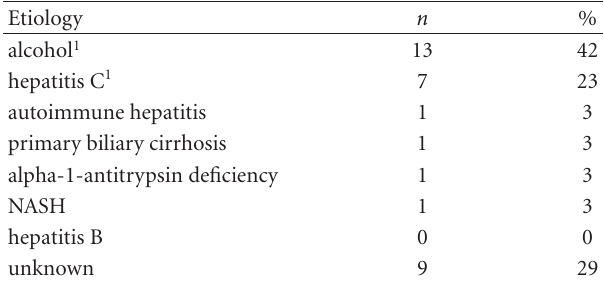
Table 2: Etiology of cirrhosis in 31 patients with